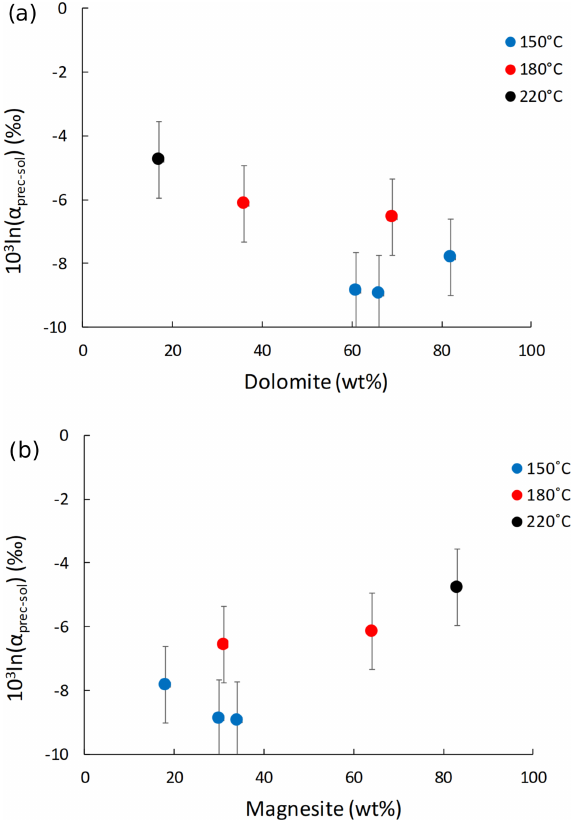
Figure 2. Lithium isotope fractionation factor between the pre- cipitated solid and the solution (10 3 ln α prec-sol ) as a function of (a) dolomite and (b) magnesite content (in wt%).